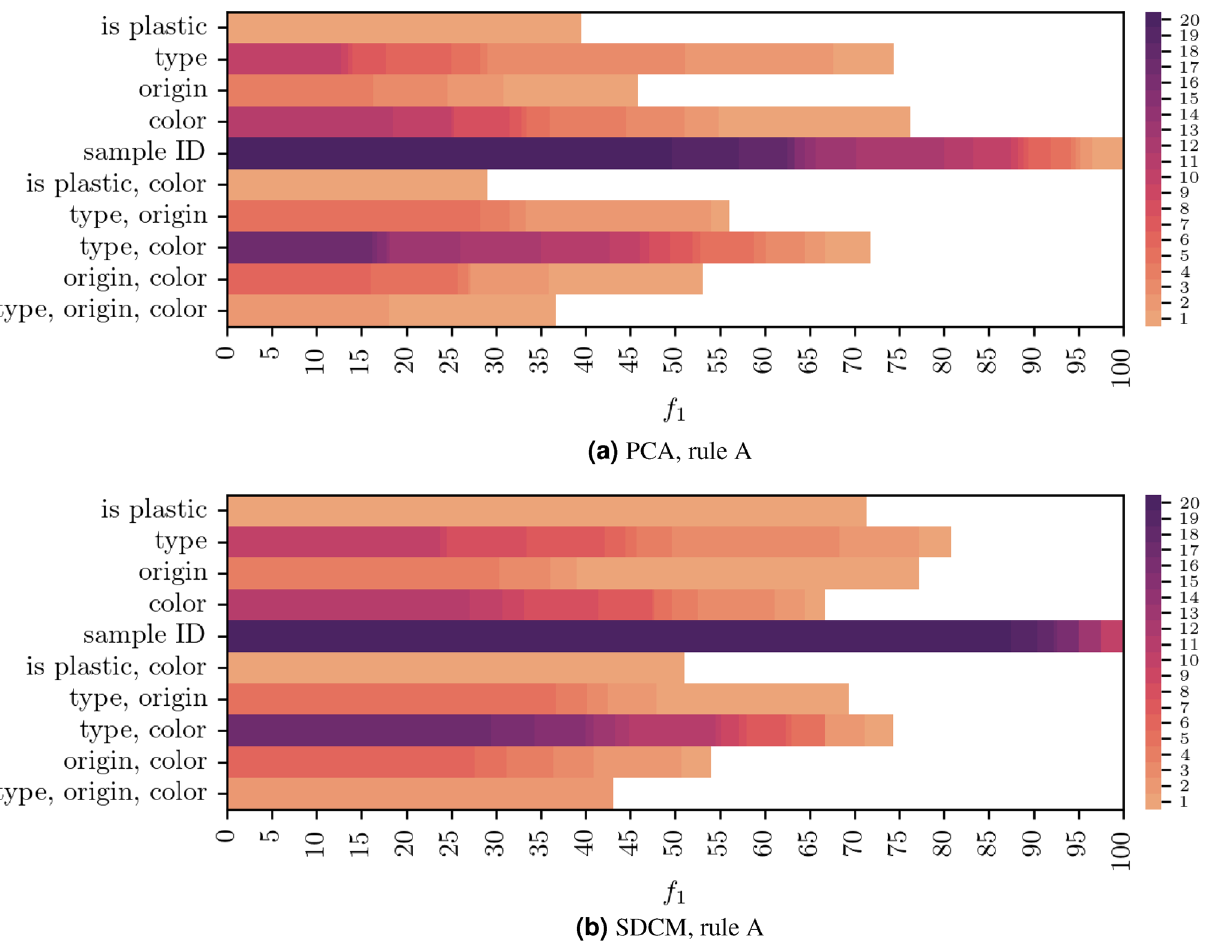
Figure 5. ( a ) PCA, rule A. ( b ) SDCM, rule A. Cumulative distributions of matched labels over f 1 in the categories defined by rule A. For each set of categories, which are defined by rule A, the figures show the number of labels that can be matched with at least one cluster at a given f 1 score or higher. The color scale is capped at 20 to improve